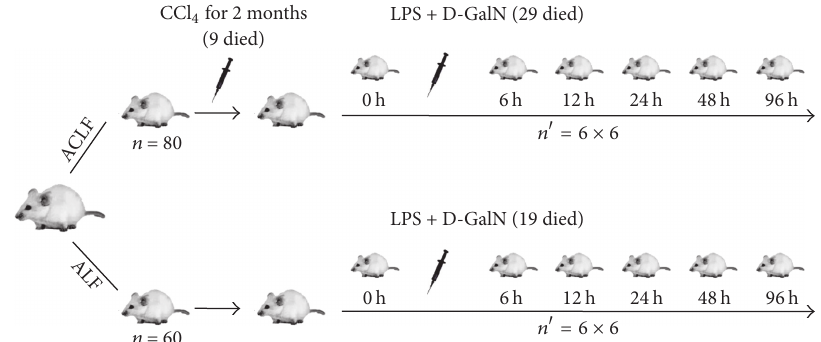
Figure 1: The process of making models of ACLF and ALF. All rats were classified into two groups randomly: ALF group and ACLF group. (1) ACLF group: the rats were treated with CCl 4 dissolved in peanut oil (volume, 1: 1) 1.5 mL/Kg weight in the 1st month and 2.0 mL/Kg weight in the 2nd month once every three days; six rats were selected as the baseline control and named “0h”; the rest rats were treated with 500 mg/Kg weight D-GalN and 80 𝜇 g/Kg weight LPS, and five time points were selected. (2) ALF group: no treatment was received for two months; subsequent treatments of ALF group were the same as ACLF group (ALF: acute hepatic failure; ACLF: acute-on-chronic liver failure; CCl 4 : carbon tetrachloride; D-GalN: D-galactosamine; LPS: